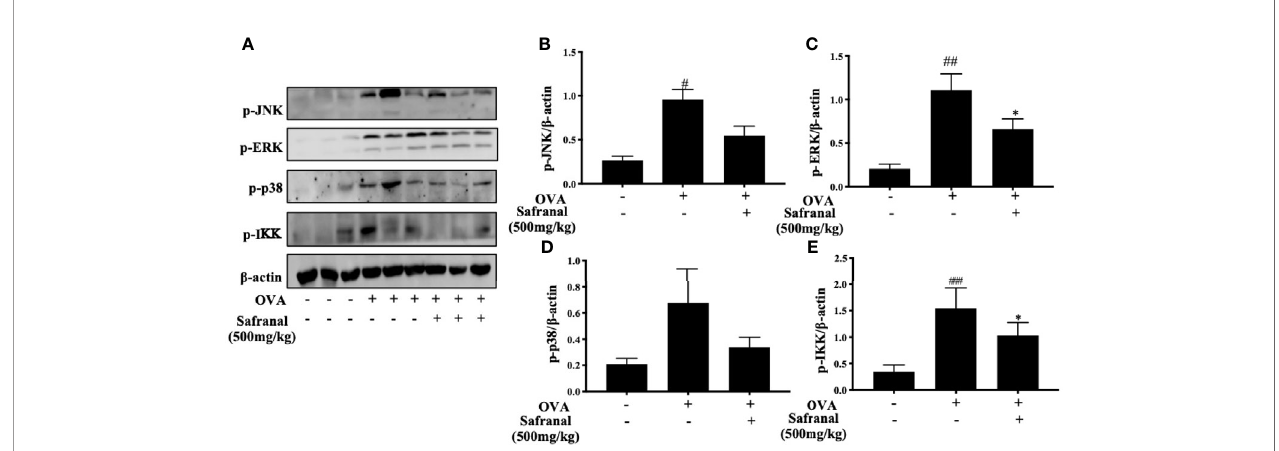
FIGURE 4 | Effect of Safranal on NF- k B and MAPKs pathways in splenocyte. Safranal suppressed the activation of the NF- k B and MAPKs pathways proteins in splenocyte (A – E) . The data are presented as the means ± S.E.M. of n = 10. # p <0.05, ## p <0.01, ### p <0.001 compared to nontreated group. * p <0.05 compared to OVA treated group.